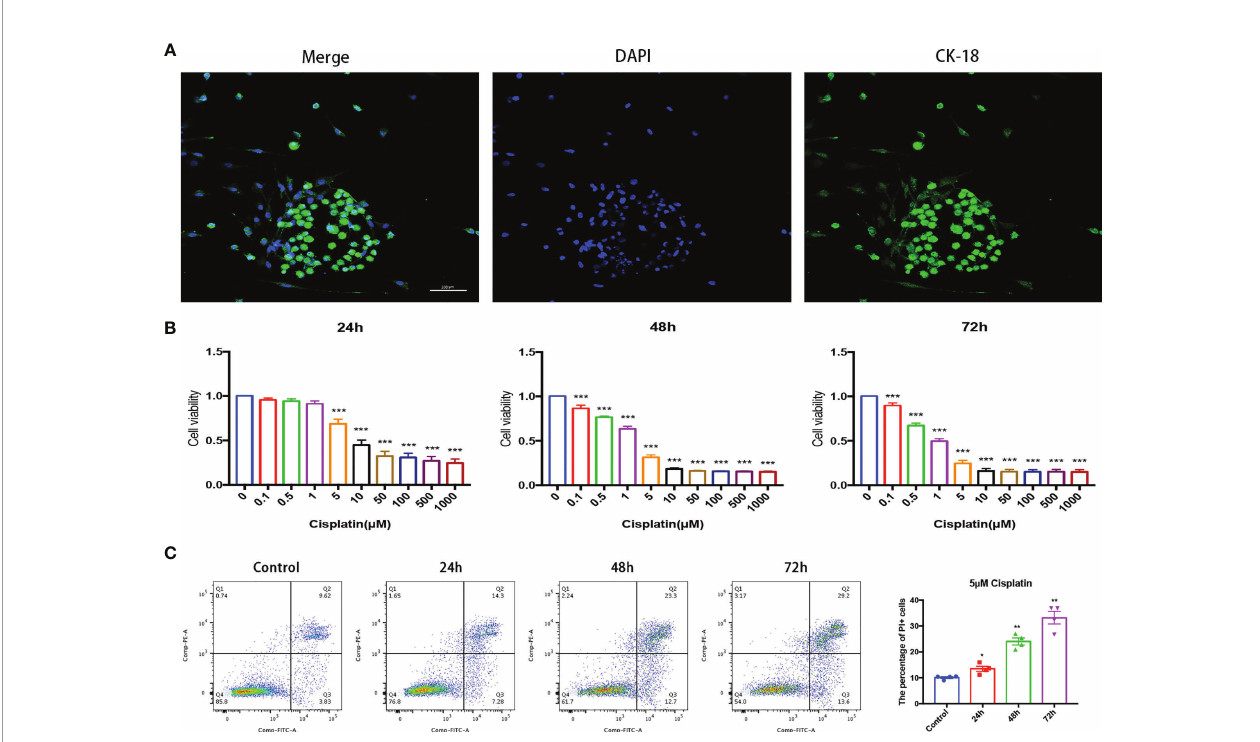
FIGURE 1 | Cisplatin induced MC damage in vitro in a time- and concentration-dependent pattern. (A) MCs grow in clumps and express CK-18 characteristically. Scale bar: 200 µm. (B) Cell viability of MCs under cisplatin treatment at gradient concentrations of 0, 0.1, 0.5, 1, 5, 10, 50, 100, 500, and 1,000 ( m mol/L) for 24, 48, and 72 h, respectively. (C) Representative images that cisplatin induced the variation of the proportion of MCs with membrane rupture (PI+, the percentage of cells in Q1 and Q2 quadrant) with the time prolongation detected by fl ow cytometry. The control group was not treated with cisplatin, and the other groups were treated with 5 m mol/l cisplatin for 24, 48, and 72 h, respectively. The above experiment was repeated at least 3 times. *p < 0.05, **p < 0.01, ***p <